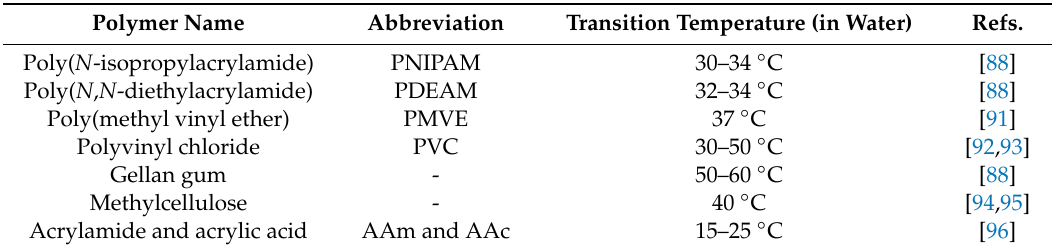
Table 1. Phase transition temperatures for selected polymers with LCST and